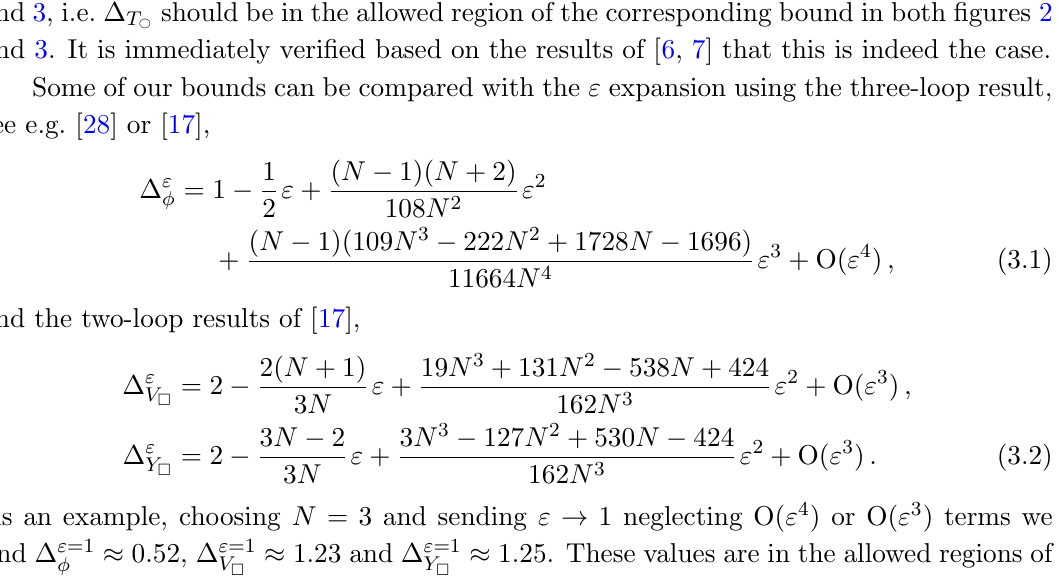
Figure 4 . Upper bound on the dimension of the (cid:12)rst vector operator in the A (cid:0) OPE as a function of the dimension of (cid:30) . Areas above the curves are excluded in the corresponding